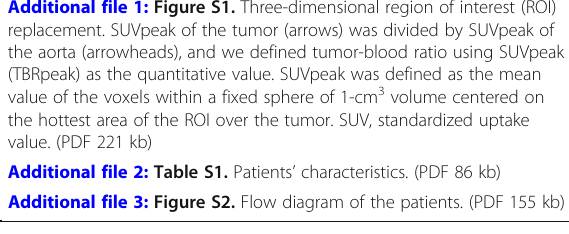
Additional file 2: Table S1. Patients ’ characteristics. (PDF 86 kb) Additional file 3: Figure S2. Flow diagram of the patients. (PDF 155